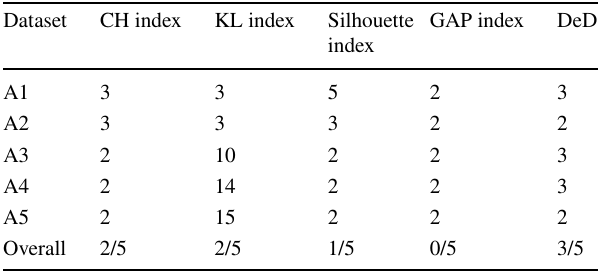
Table 2 Simulation study on synthetic datasets with 3 high variance